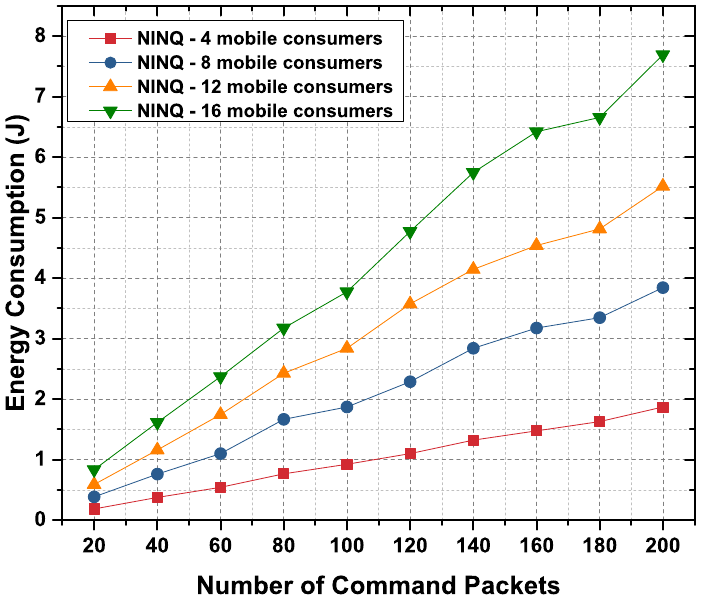
Figure 15. Energy consumption in an NINQ-based network as function of the number of